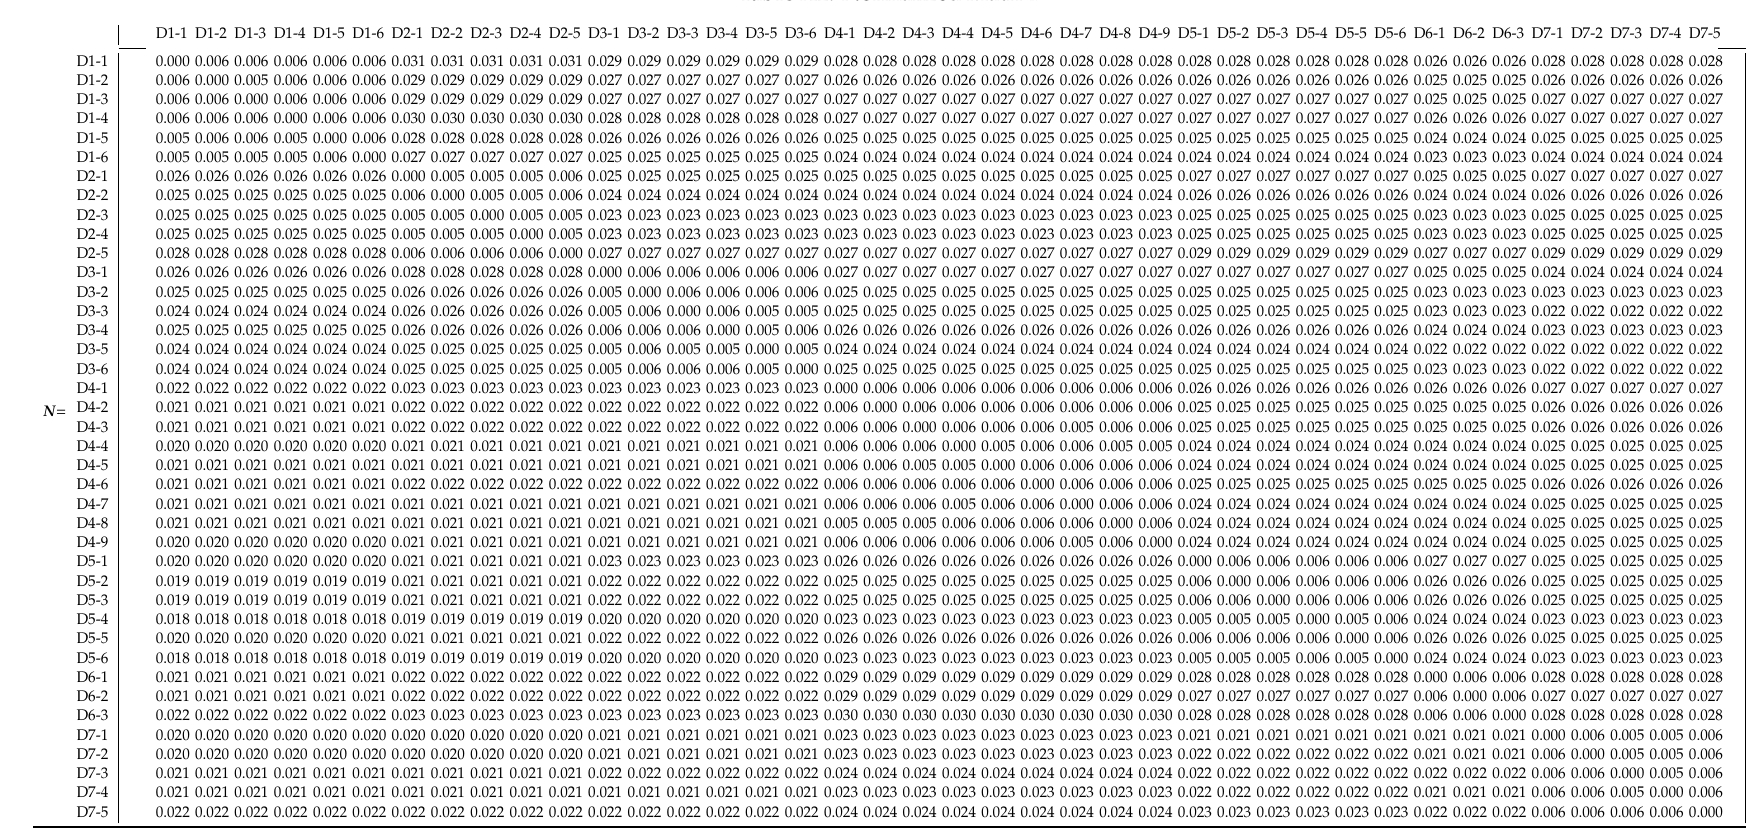
Table A2. Normalized